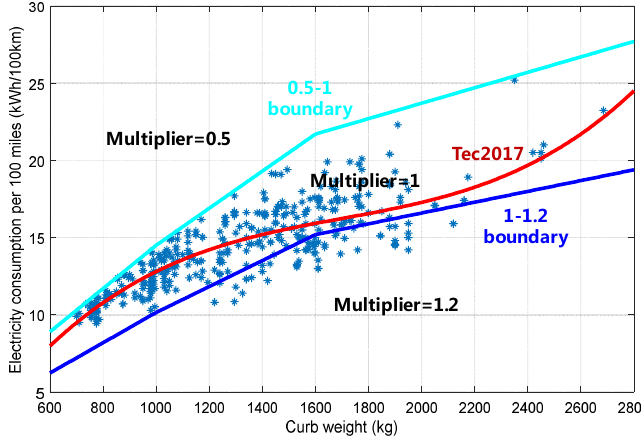
Figure 4. The electricity consumption rate and the multiplier γ in the NEV credit regulation. Notes. (1) The market is divided into three regions by the green and blue boundaries, and the vehicles in each region receive a certain credit multiplier, i.e., 0.5, 1, or 1.2, as indicated in Equation